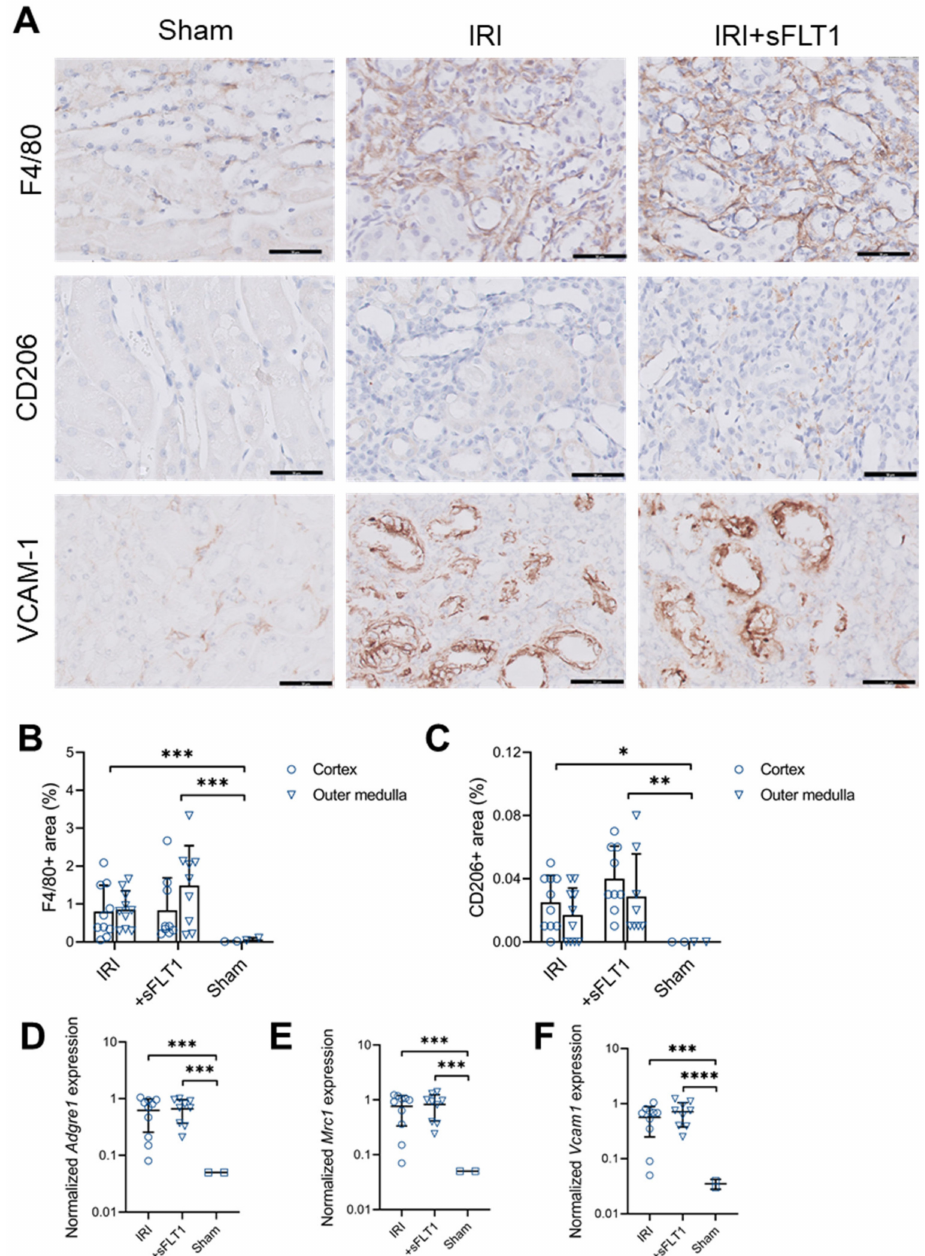
Figure 4. sFLT1 does not affect chronic macrophage infiltration after IRI. ( A ) Representative images of renal F4/80, CD206 and VCAM-1. Scale bars, 50 µ m. ( B ) F4/80-positive areas were quantified in cortex and outer medulla. Linear mixed model using log-transformed values. ( C ) CD206-positive areas were quantified in cortex and outer medulla. Linear mixed model using arcsine-transformed CD206 data. Quantitative PCR for ( D ) Adgre1 , ( E ) Mrc1 and ( F ) Vcam1 was performed on whole- kidney mRNA. One-way ANOVA, **** p < 0.0001, *** p < 0.001, ** p < 0.01, * p <